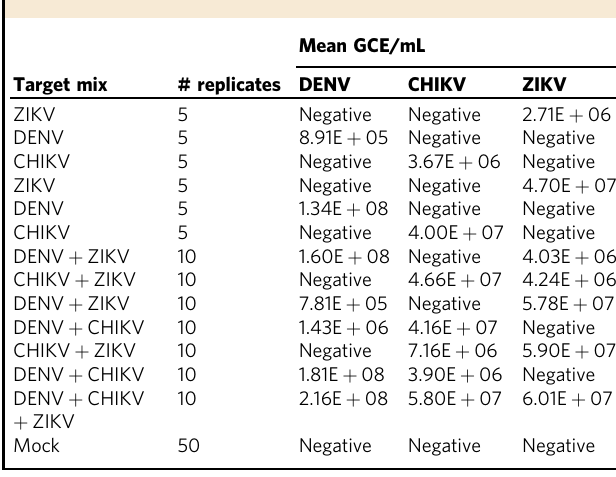
Table 1 Mixed virus RNA detection in serum from acute febrile illness patients negative for dengue, chikungunya, and Zika viruses